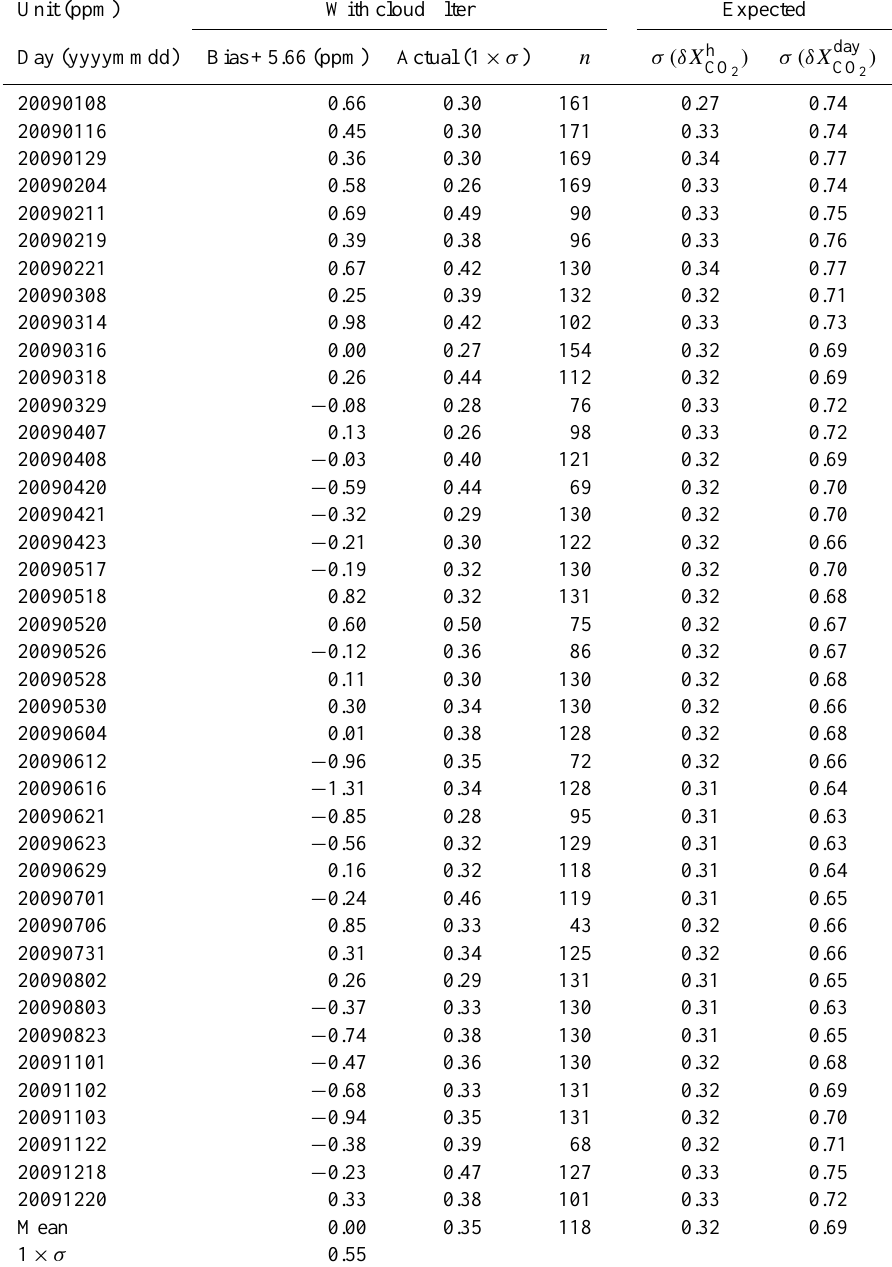
Table 2. Lists of bias error and its standard deviation (1 × σ ) of TCCON profile retrieved column averages within 4-h time window of each flight measurement. The expected uncertainties from measurement error covariance and the temperature error covariance are also listed in the last two columns. To remove the unclear sky spectra measurements, we dismiss the retrievals when the parameter “fvis” (fractional variation in solar intensity) is greater than 0.05, which suggests the cloud coverage during the spectra measurement. By applying the cloud filter, the consistency between the empirical error estimates and expected error estimates is improved. The columns for “ n ” are the total numbers of retrievals within 4-h time